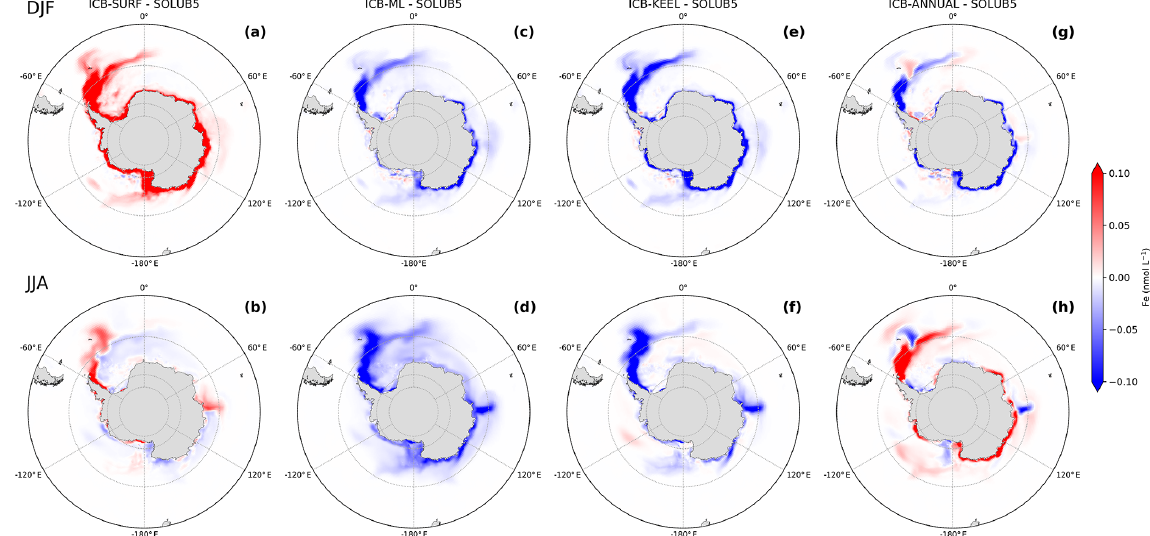
Figure 4. Difference in surface Fe concentrations between the (a, b) ICB-SURF, (c, d) ICB-ML, (e, f) ICB-KEEL, and (g, h) ICB-ANNUAL experiments and the SOLUB5 experiment (experiments minus SOLUB5) in (a, c, e, g) summer (December, January, and February) and (b, d, f, h) winter (June, July, and August) in the Southern Ocean, south of 45 ◦ S. Positive values in red are regions with surface Fe concentrations higher than in the SOLUB5 experiment, and negative values in blue are regions with surface Fe concentrations lower than in the SOLUB5 experiment.